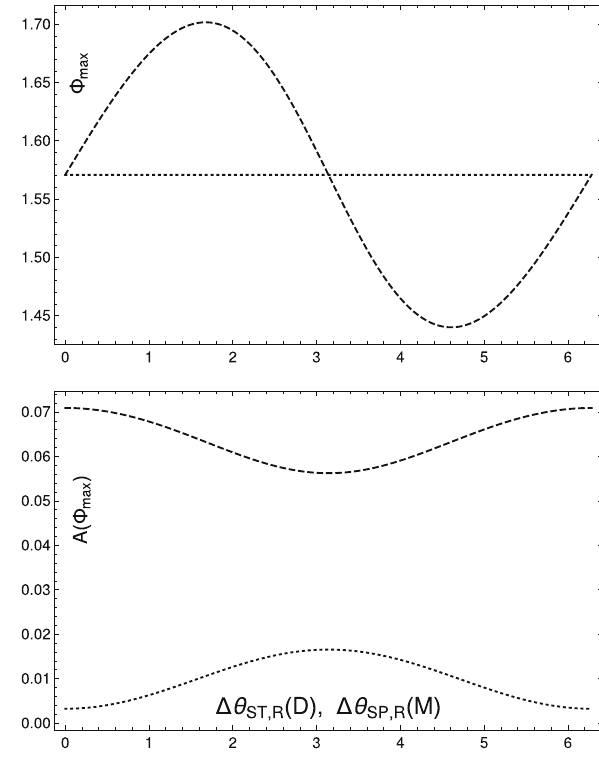
Fig. 3 Upper plot (dashed line) is the dependence of Φ max on Δθ ( D ) for Dirac ν ST , R e in case of V – A , S R and T R interactions when | c R | = | c R | = 0 . 2. Upper plot (dotted line) is the dependence of S T Φ Δθ ( M ) for Majorana ν max on SP , R e in case of V – A , S R and P R cou- | = | c R | = 0 . 2. Both scenarios assume ˆ η ν · ˆ q = − 1, plings when | c R S P θ = π/ 2 , E ν = 1 MeV . Lower plot is the dependence of A (Φ ) on max 1 Δθ ( D ) for Dirac ν Δθ ( M ) for Majorana ST , R e (dashed line) and on SP , R Φ ν e (dotted line), respectively, with same assumptions as for max